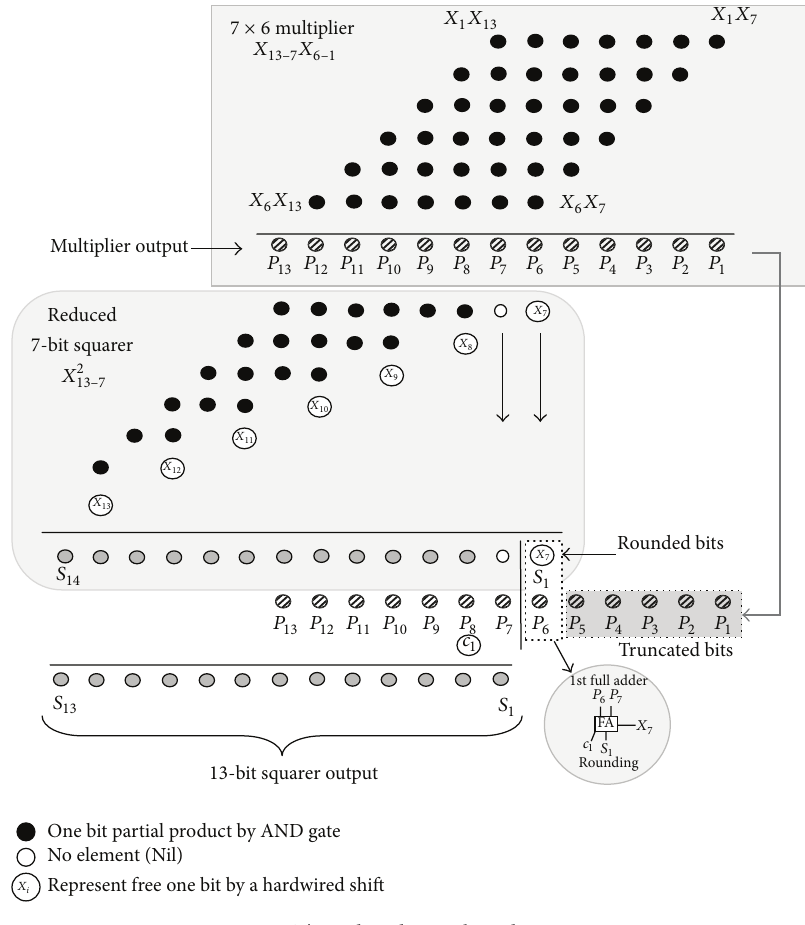
Figure 11: The reduced partial products matrix.